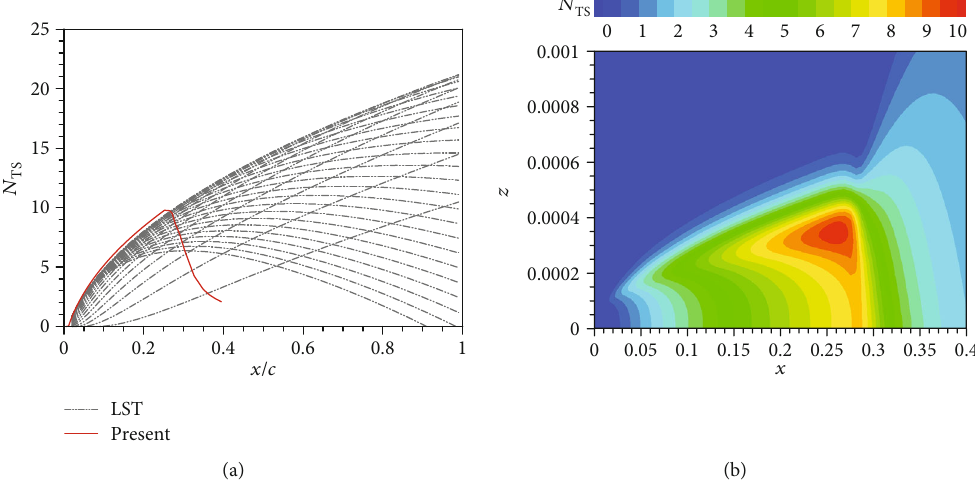
Figure 7: Predicted results of ampli fi cation factor (a) Comparison with standard LST analysis results; (b) contour at Mach number = 3 : 5 and Reynolds number = 5 : 89 × 10 7 /m .